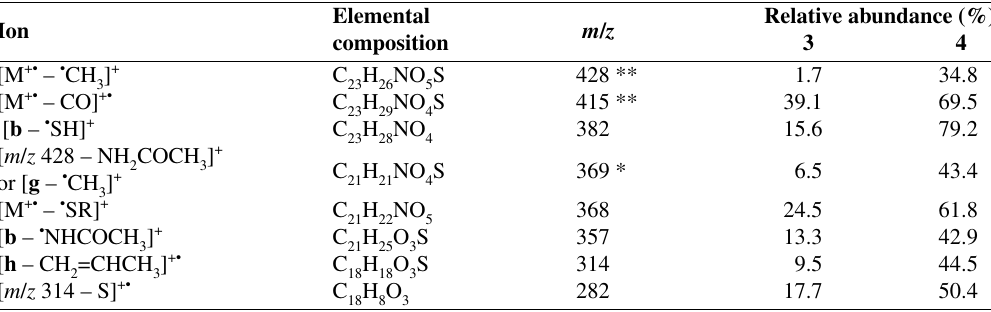
Relative abundance (%) m / z